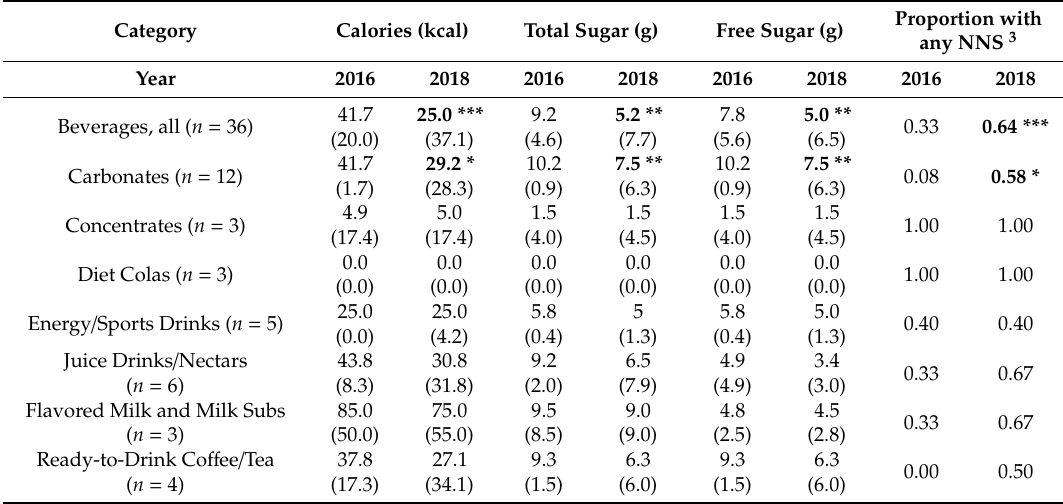
Table 2. Median (IQR) quantity of selected nutrients of concern per 100 mL by beverage type 1,2